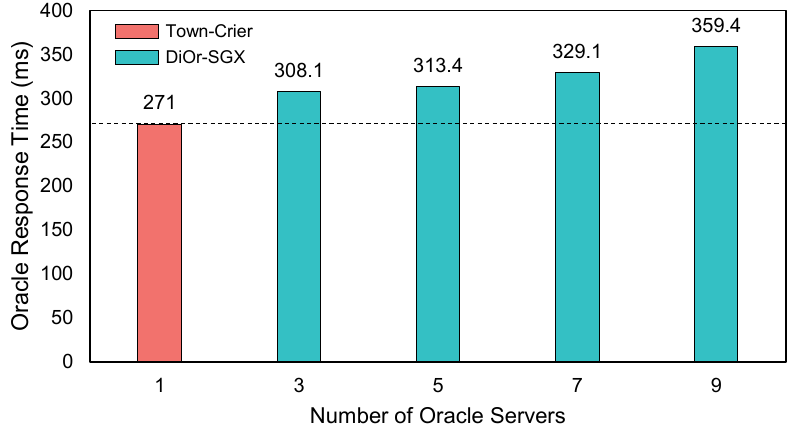
Figure 9. Comparison of Response Time (Town-crier vs